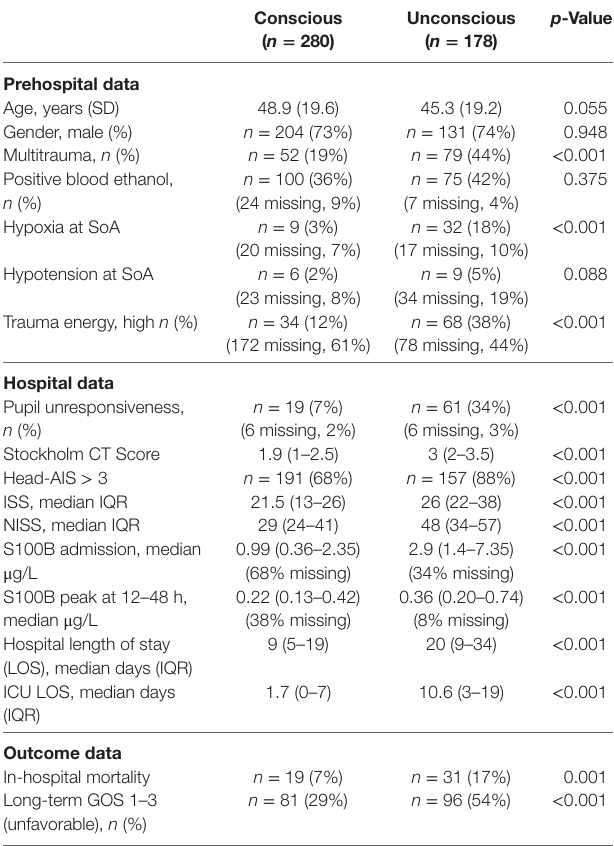
Table illustrating the demographic data between conscious and unconscious patients. Missing data are mentioned for each parameter, if present. Difference between groups are compared using chi-square or Mann–Whitney test, were applicable. SoA, scene of accident; CT, computerized tomography; AIS, Abbreviated Injury Scale; ISS, Injury Severity Score; NISS, New Injury Severity Score; ICU, intensive care unit; GOS, Glasgow Outcome Score; IQR, interquartile